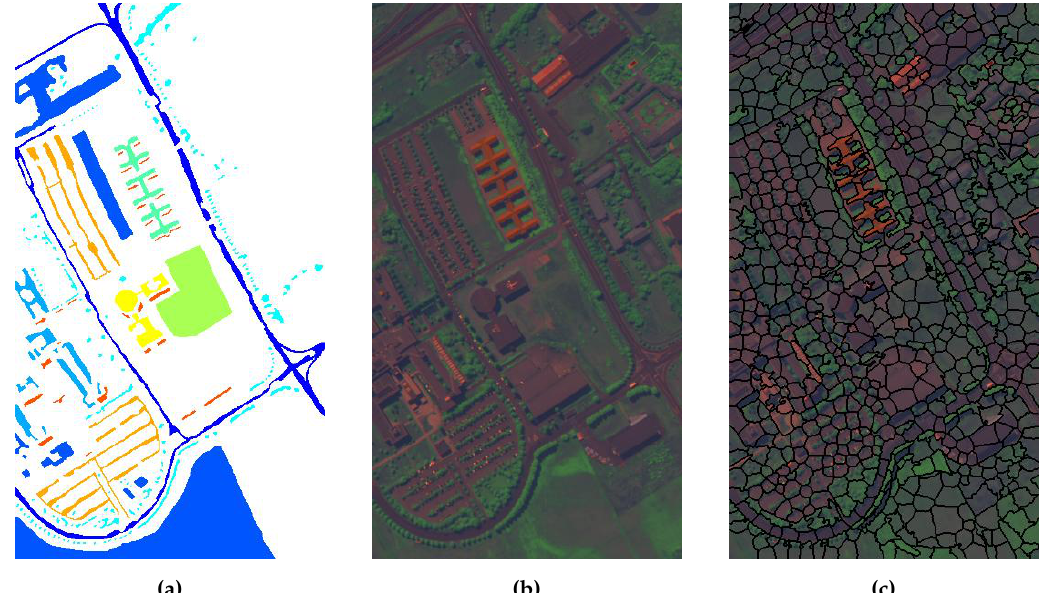
Figure 2. The superpixel generation process of the PaviaU dataset. ( a ) the ground truth, ( b ) the first three components of the HSI data, ( c ) the produced superpixel